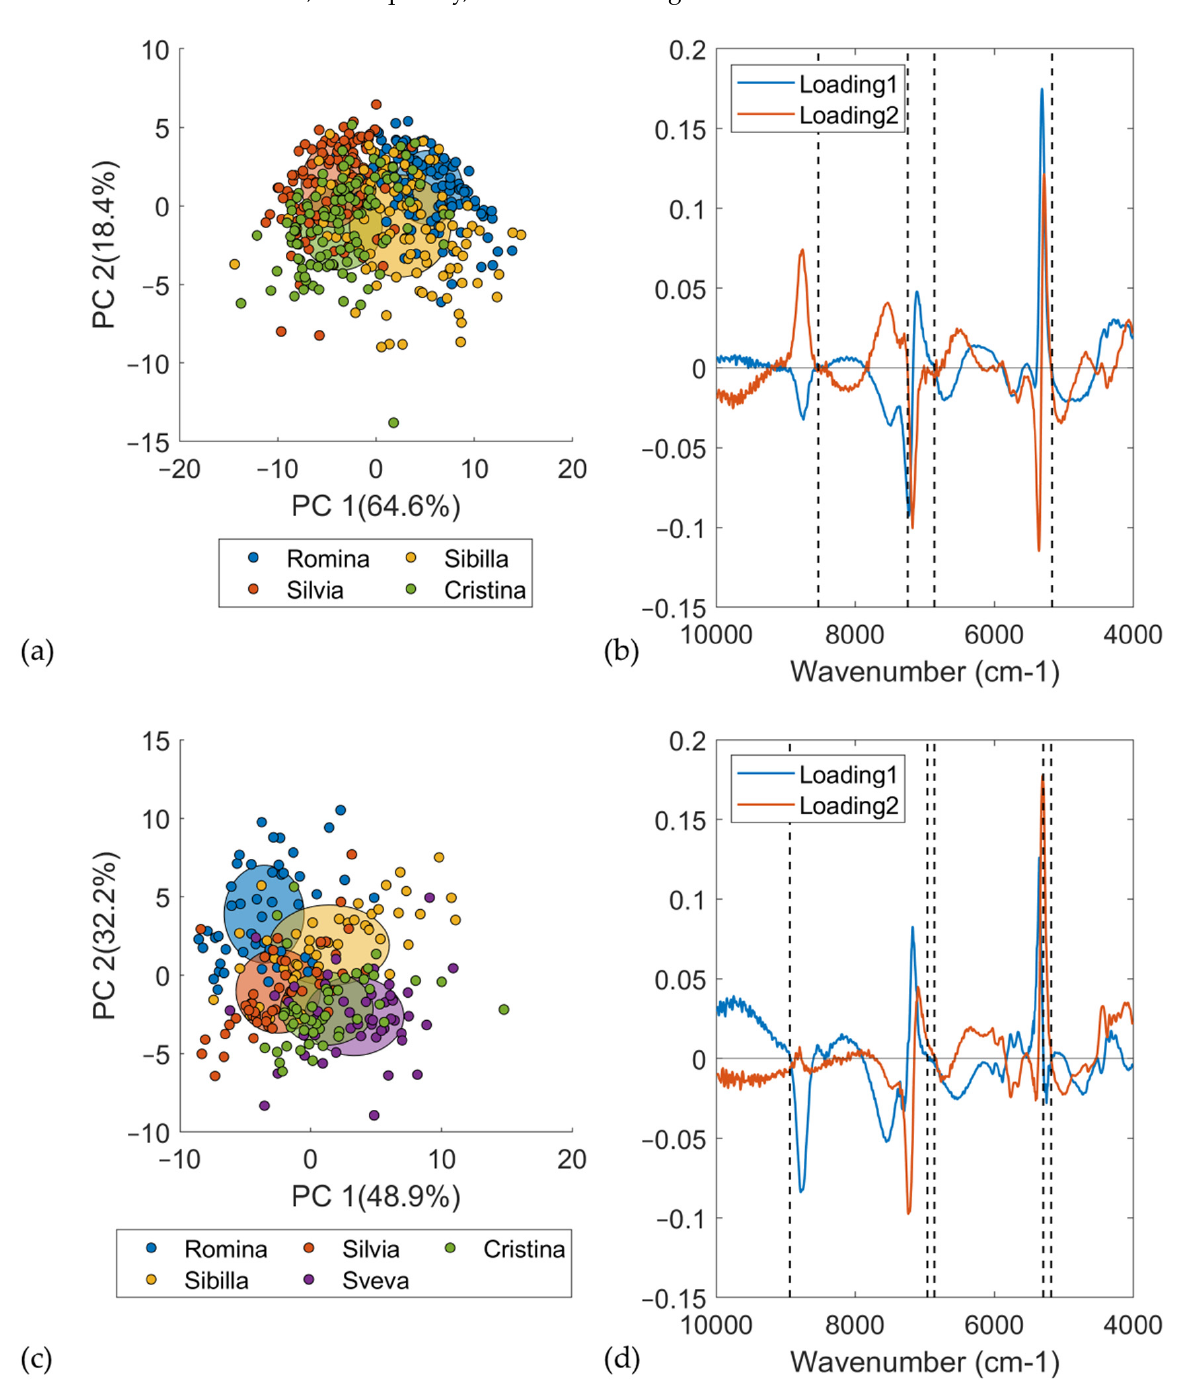
Figure 5. PCA score plots of the two first principal components ( a ) and the respective loadings based on the pretreated spectra of the DB-2020 samples ( b ). PCA score plots of the two first principal components ( c ) and the respective loadings based on the pretreated spectra of the DB-2021 samples ( d ). The most important wavenumbers are marked with vertical dotted lines.